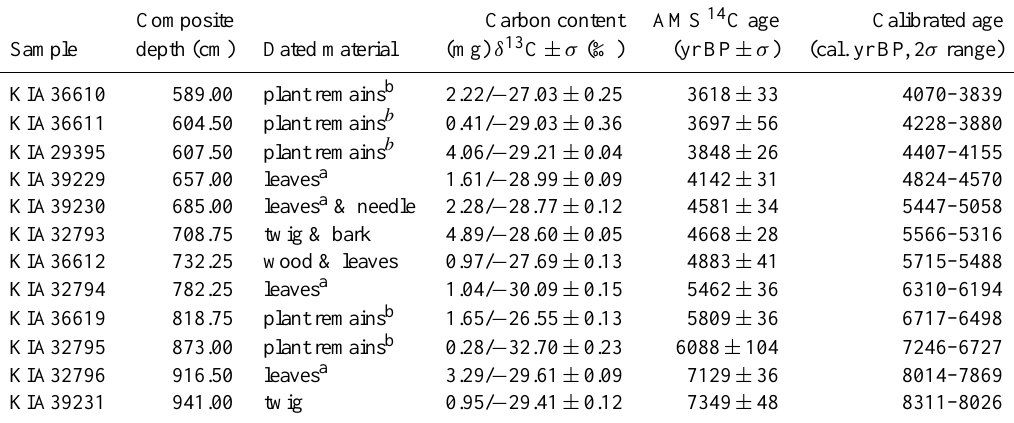
Table 2. Selected AMS 14 C dates obtained from terrestrial macrofossils from the Lake Mondsee sediment core. All conventional 14 C ages were calibrated using the OxCal 4.1 program (Ramsey, 1995, 2001, 2009) with the IntCal09 calibration data set (Reimer et al., 2009). Sample KIA32795 was rejected from age modelling with OxCal. For a full account on radiocarbon dates from the Lake Mondsee sediment record and the primary varve-based age model see Lauterbach et al. (2011).